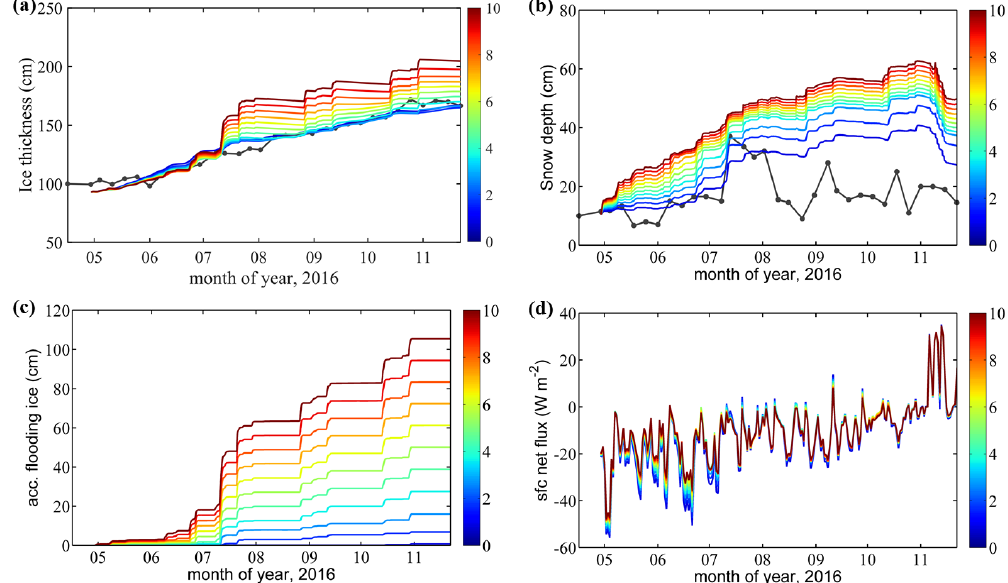
Figure 5. Time series of the simulated (a) sea ice thickness, (b) snow depth, (c) accumulated flood ice, and (d) net surface heat flux in the n experiments of SEN3. The solid black point lines show the in situ observations (Obs). The 11 colored lines denote the 11 sensitivity experiments. When n = 0, precipitation is from the in situ observations. When n = 10, precipitation is from